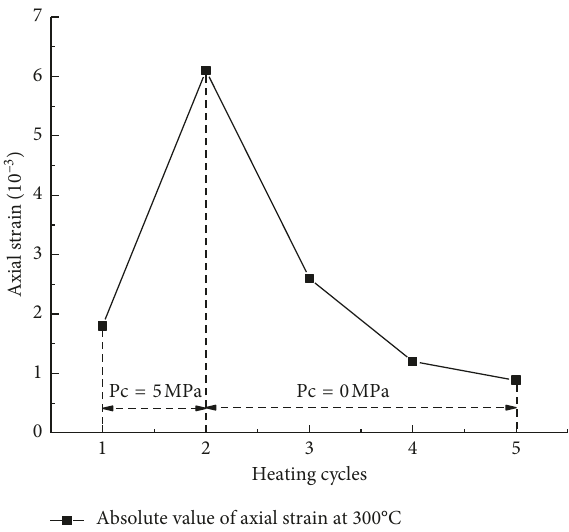
Figure 4: Change of axial strain at 300 ° C versus the number of heating